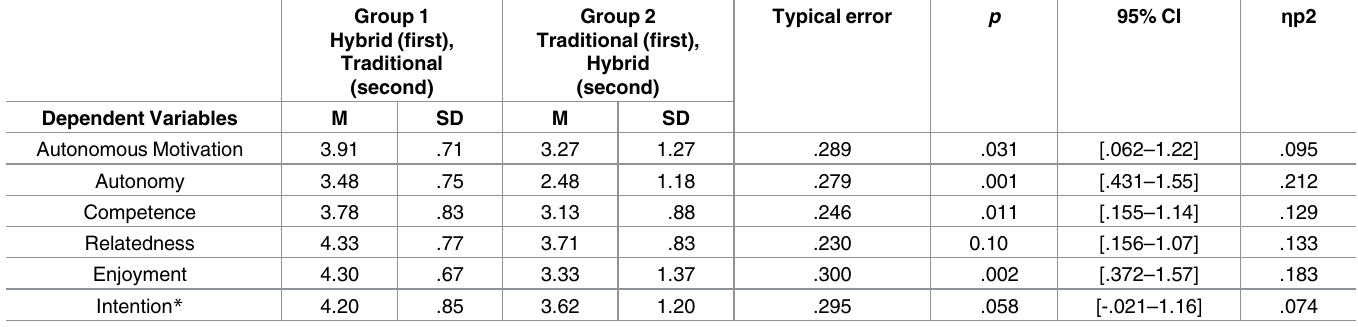
Table 3. Descriptivestatistics and inter-group analysis of each dependent variable in